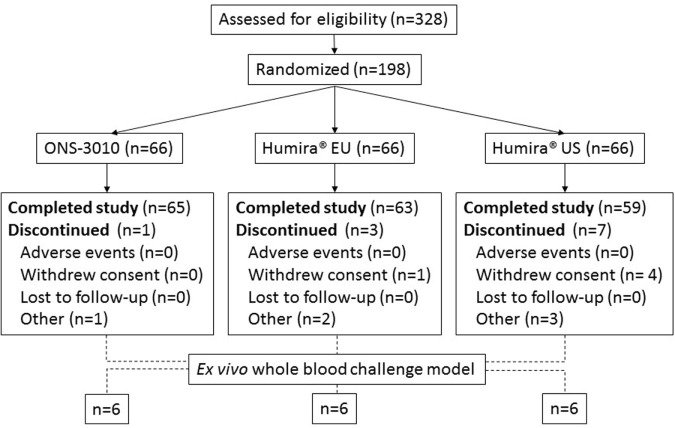
Subject disposition.